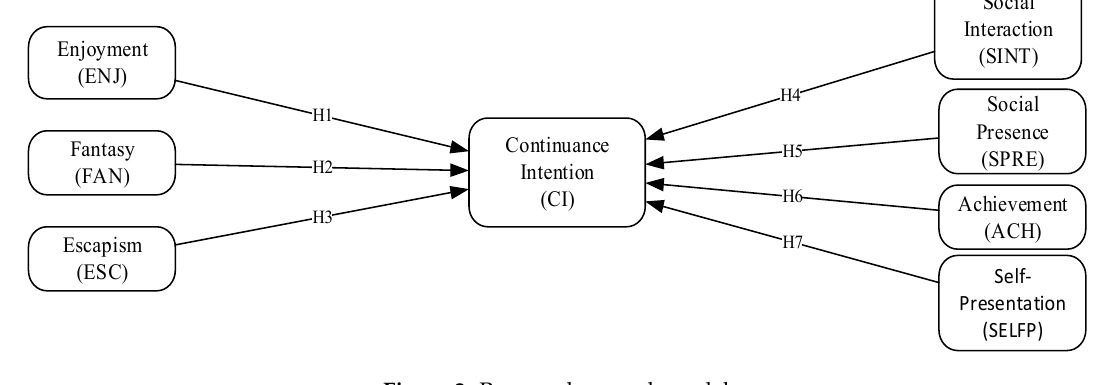
Figure 2. Proposed research model.